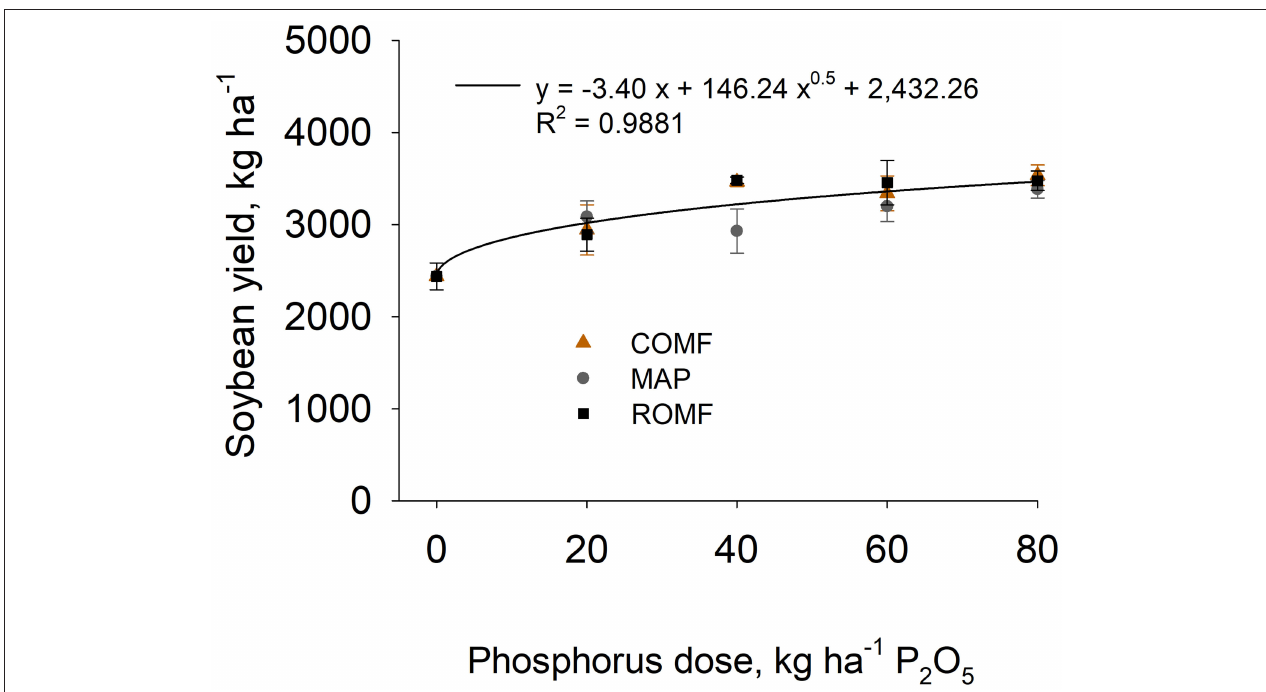
FIGURE 7 | Soybean yield in the crop season of 2015/2016 using the residual P after 5 crop seasons with organomineral and mineral fertilization. COMF, composted organomineral fertilizer; MAP, monoammonium phosphate; ROMF, row poultry litter organomineral